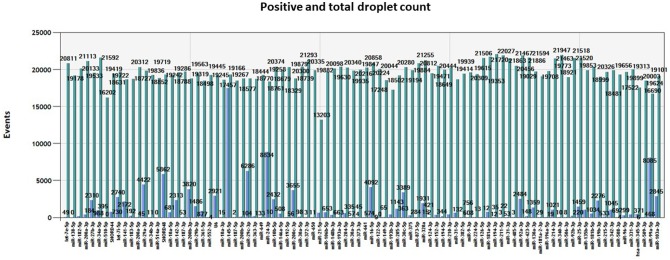
Number of events. Total number of positive (blue) and negative (green) droplets visualized in QuantaSoft software (Bio-Rad) for each miRNA assay assessed in the same tumor sample.